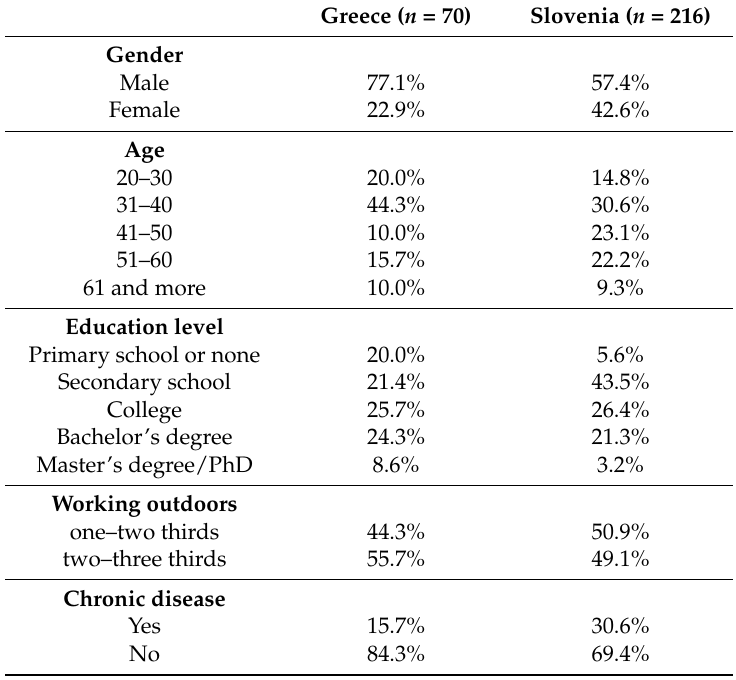
Table 1. A comparison of the questionnaire’s results in Greece and Slovenia—description of the